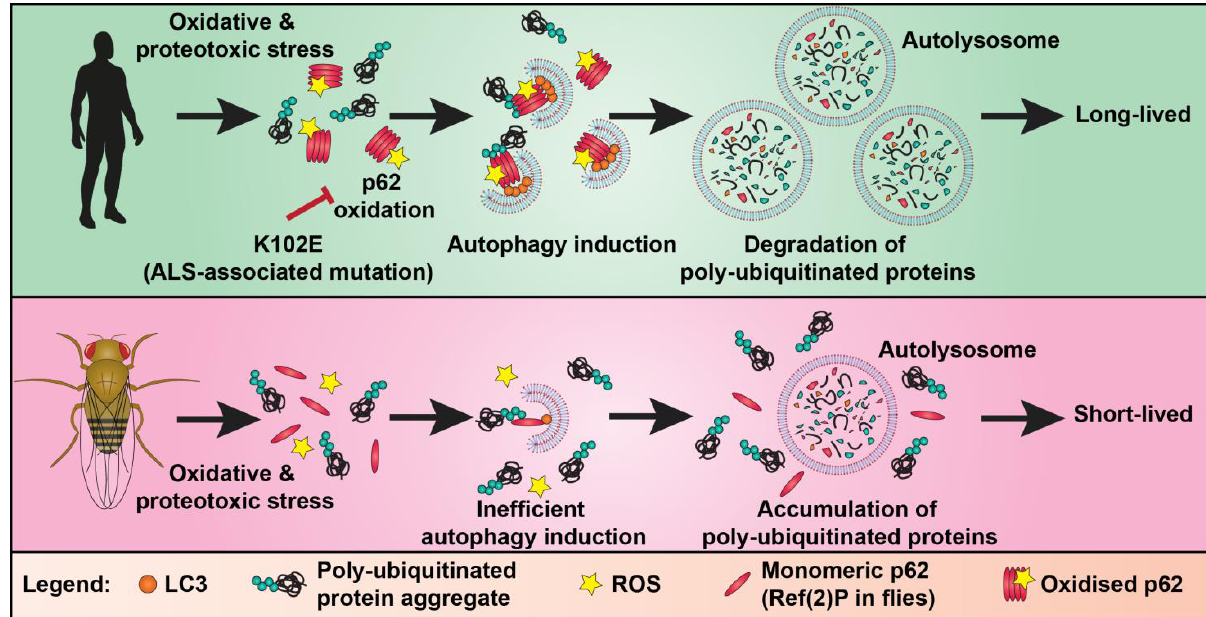
FIGURE 1: Diagram of the proposed evolutionary adaptation to the autophagy machinery involving oxidation of p62. Oxidative and pro- teotoxic stress triggers oxidation and oligomerisation of p62, promoting the formation of autophagosomes around poly-ubiquitinated pro- teins. After the autophagosome is fully formed it fuses with a lysosome to form the autolysosome. In the autolysosome, the cargo (e.g. poly-ubiquitinated protein aggregates and p62) is degraded by lysosomal proteases. The ALS-associated mutation K102E can impair oxida- tion of p62, resulting in less autophagy induction in oxidative and proteotoxic stress conditions. The key cysteine residues required for p62 oxidation, present in vertebrates, were acquired late in evolution. Ref(2)P, the fly homolog of p62, lacks these oxidation-sensitive cysteine residues. Introduction of the p62 redox-sensitive cysteines into Ref(2)P promotes autophagy and survival in oxidative and proteotoxic stress conditions. This suggests that longevity associated with vertebrates, like humans, is a result of evolutionary adaptations to their autophagy machinery, which allow them to better manage the age-related increase in proteotoxic